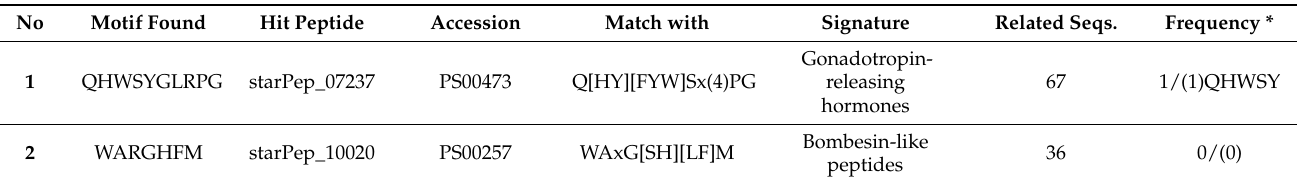
Table 8. Motifs found in